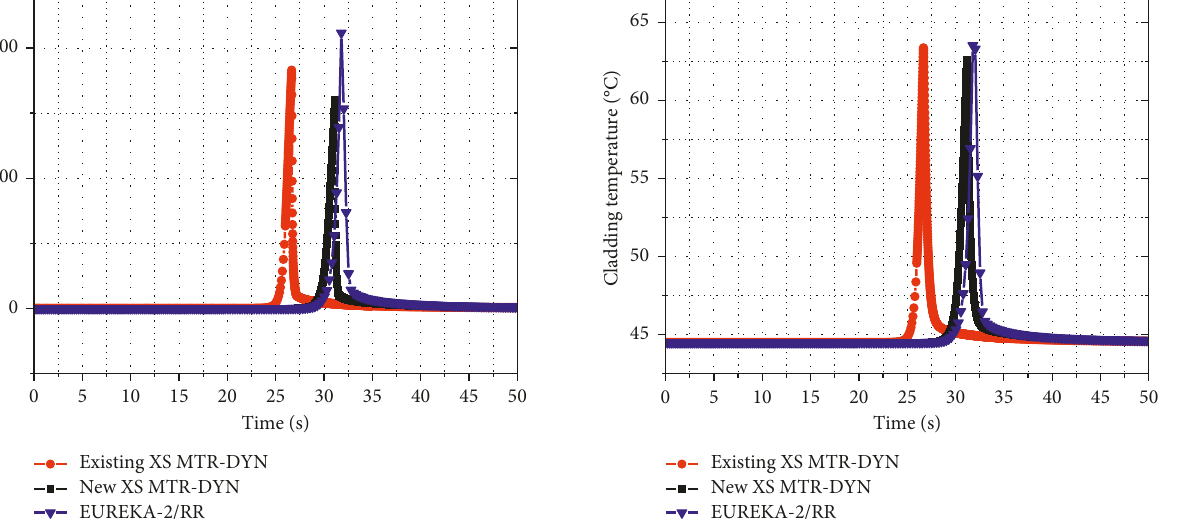
Figure 9: Reactor power response for RIA transient analysis within start-up range.